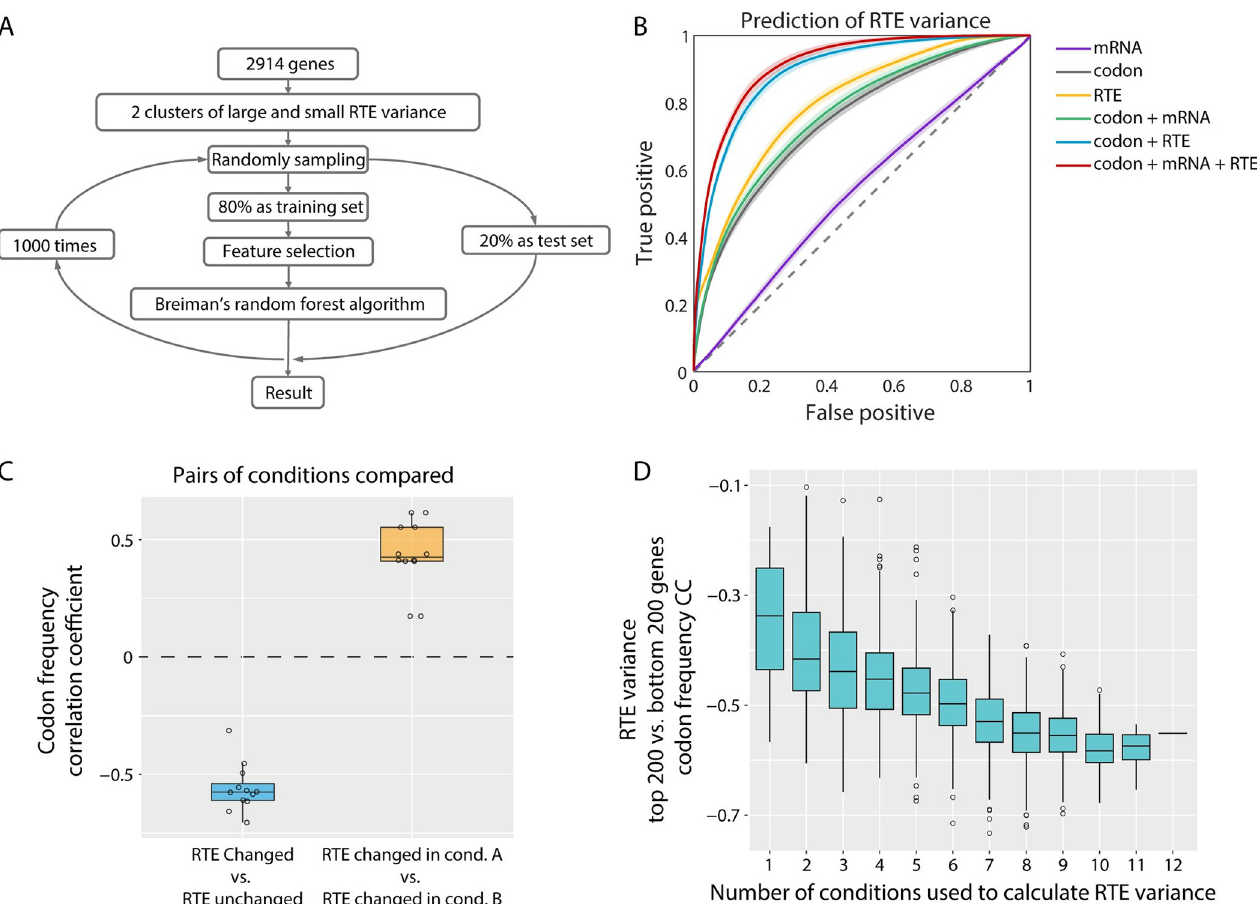
Fig 7. Codon usage contributes to RTE variability across nutrient conditions. (A) Flowchart for predicting the classification of RTE cross-condition variance using a random forest model. (B) The ROC curves of the classification accuracy using different combinations of features. An average of results for 1000 trainings was used. The shaded areas represent the S.D. Codon, mRNA, and RTE stand for the codon frequency, the mRNA level, and the RTE absolute value, respectively. (C) Codon frequency correlations (evaluated as in Fig 6C) between different gene sets when pairs of conditions were compared (Fig M in S1 Text). The yellow box shows correlations between two sets of RTE up-regulated genes in each of the paired conditions. The blue box shows correlations between RTE up-regulated and unchanged genes in each of the paired conditions. (D) The correlation coefficient was exactly as obtained in (Fig 6C), but for different numbers of conditions used to calculate the RTE variance. Each box was derived from all possibilities of taking n from the 12 conditions.